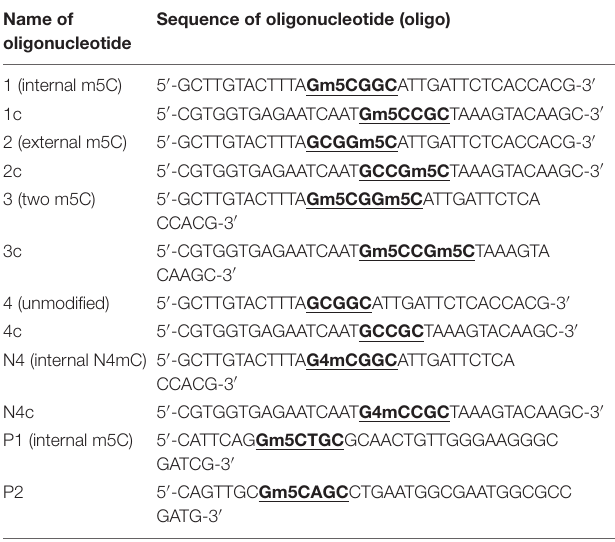
TABLE 1 | Modified DNA oligo sequences used in this